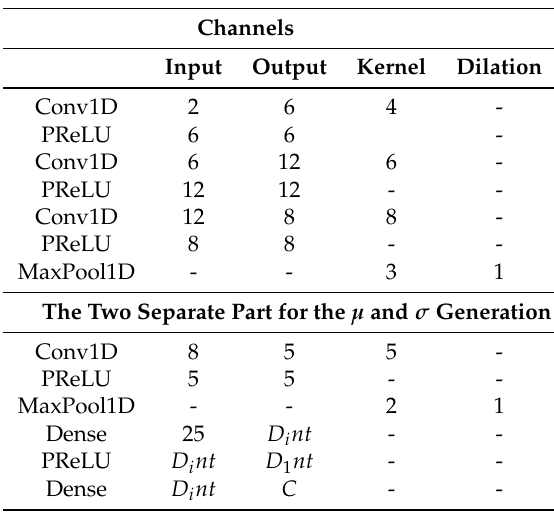
Table 1. Parameters of the Variational Autoencoder Architecture. The Parameters of the Common Part of the Encoder